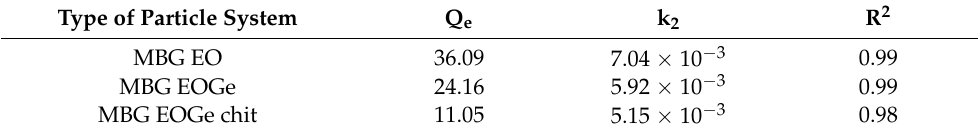
Table 2. Obtained parameters and adjust (R 2 ) for the release mechanism (pseudo second